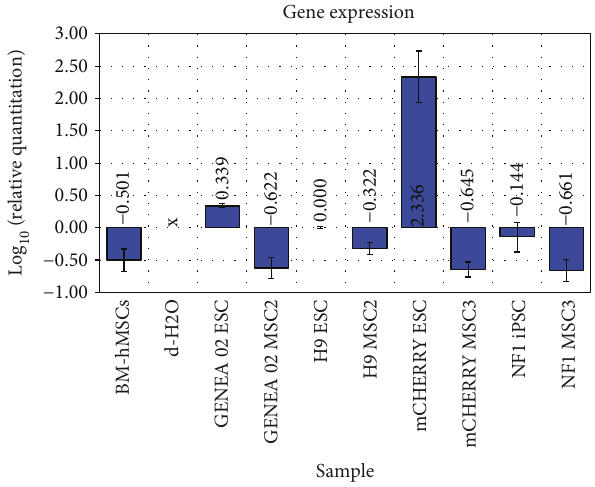
Figure 5: Oct-4 expression analysis of undi ff erentiated iPSCs/ESCs, BM-hMSCs, and iPSC/ESC-derived MSCs. The expression of Oct-4 was downregulated in BM-hMSCs and iPSC/ESC-derived MSCs in comparison with the undi ff erentiated iPSCs and ESCs. Gene expression was normalized to 18S. Three technical replicates were performed for each